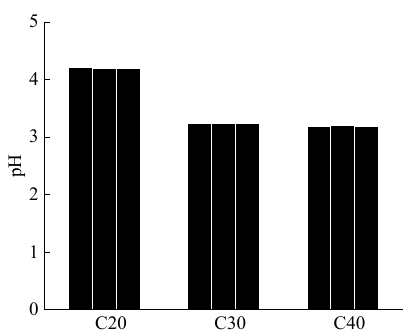
Figure 9. The pH of the powdery precipitated substances at different water–cement ratios. Three Figure9. ThepHofthepowderyprecipitatedsubstancesatdi ff erentwater–cementratios. Threesamples samples were tested for each water–cement ratio. were tested for each water–cement